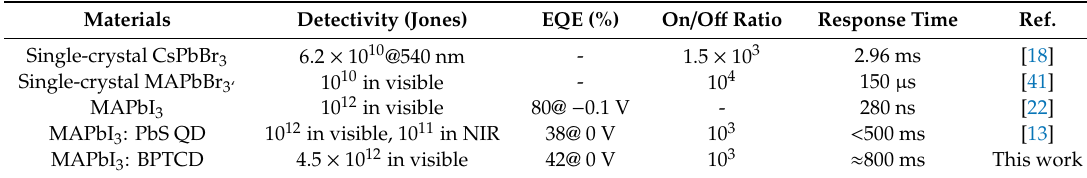
Table 2. Performance summary of reported perovskite-based